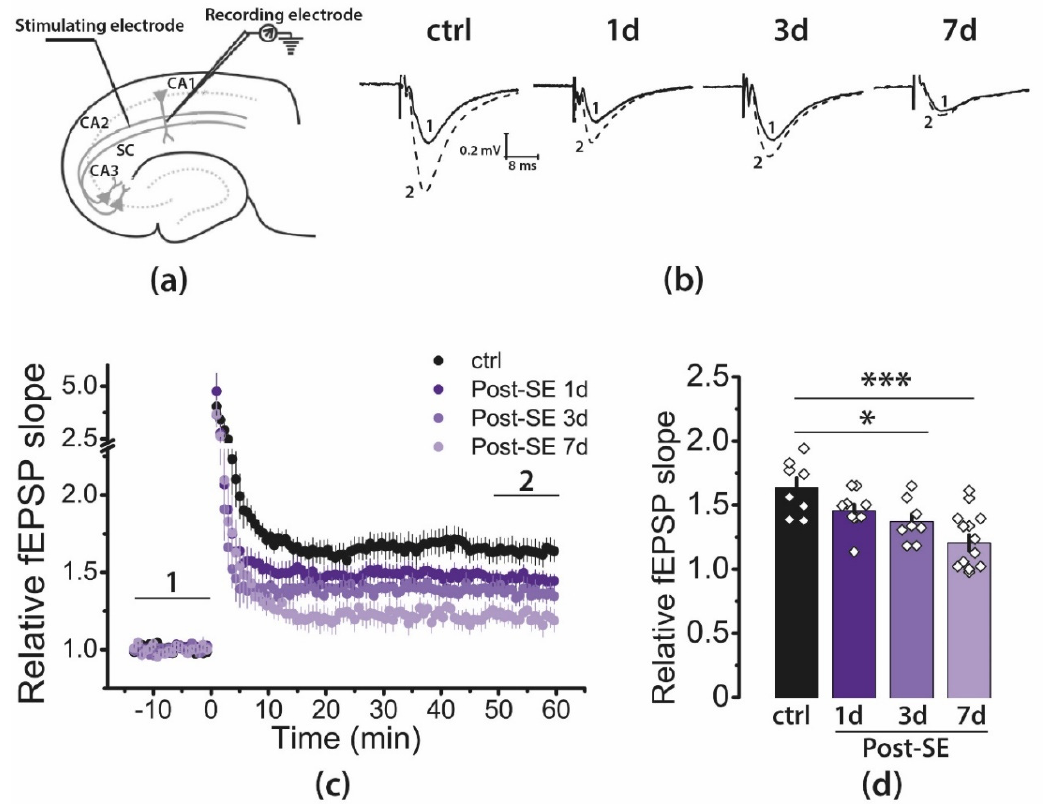
Figure 3 . LTP is attenuated in the CA1 hippocampal area in post-SE rats. ( a ) Schema showing the positions of electrodes in the hippocampus. ( b ) Representative examples of fEPSP were recorded before induction (1) and 50–60 min after HFS (2). ( c ) Diagram showing the normalized slope of fEPSP in control (ctrl) and post-SE groups (1d; 3d; 7d). ( d ) Bar diagram illustrates differences in LTP value between groups. Seven to ten animals were in each group. One or two brain slices were used from one animal. The diamonds show the individual values for each brain slice. All data are presented as a mean ± standard error of the mean. One-way ANOVA F 3,32 = 8.85, p < 0.001; Tukey’s post hoc test reveals the significant differences with control group: * p < 0.05, *** p < 0.001.